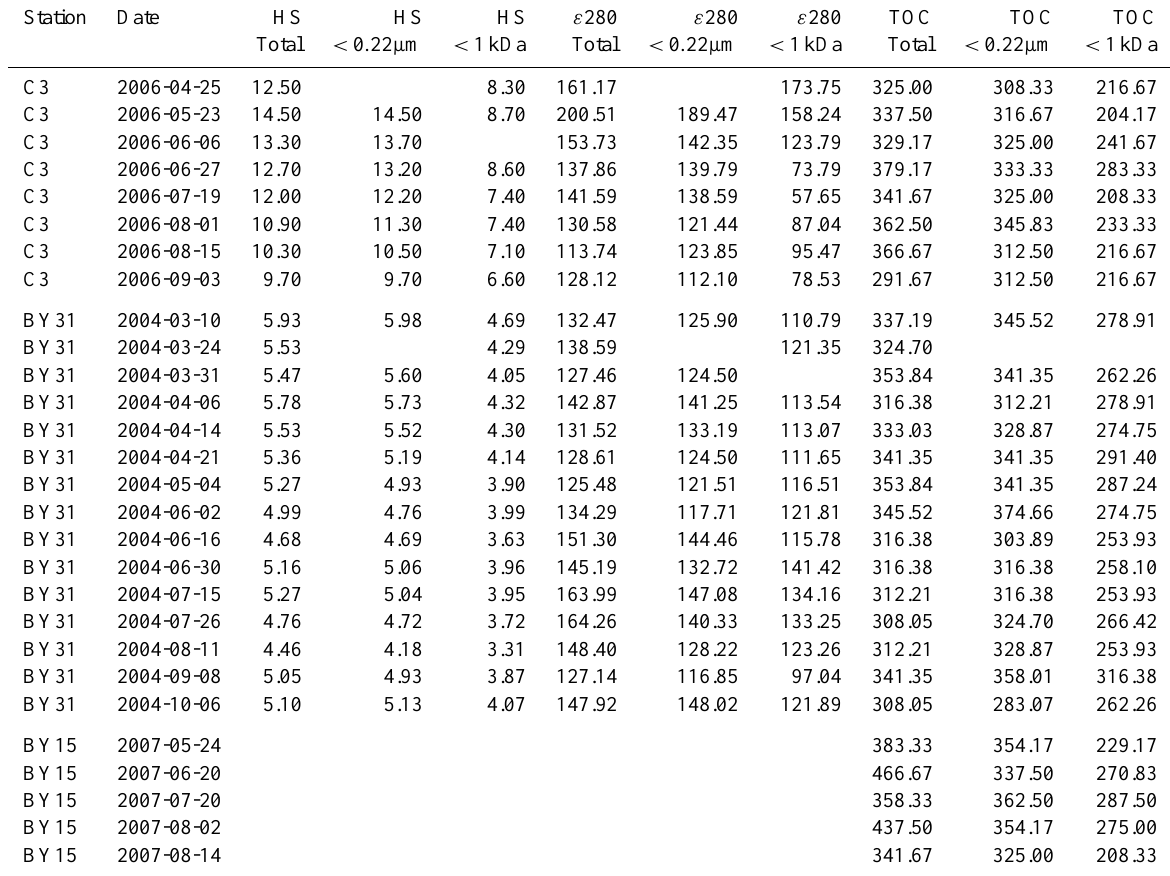
Table 3. Humic substances (HS; µg/L, QSE), ε 280 and total organic carbon (TOC; µM) in different size fractions at the Bothnian Sea (C3), Landsort Deep (BY31) and Gotland Deep